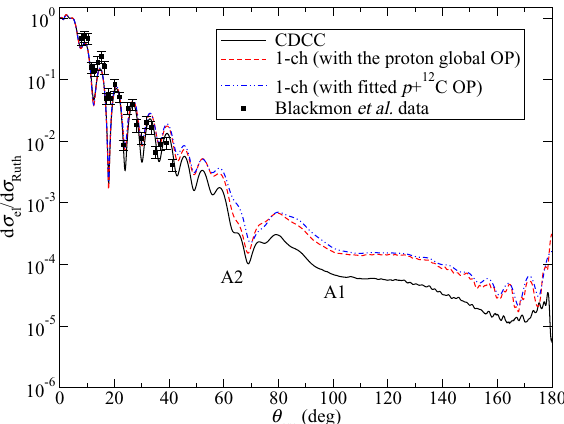
Figure 1. The elastic scattering angular distribution of 17 F + 12 C at 170 MeV. The solid squares denote the experimental data ex- tracted from Ref. [15]. The curves represent the results of the CDCC and 1-ch calculations. For the 1-ch calculations, the pro- ton OP used is the global or fitted